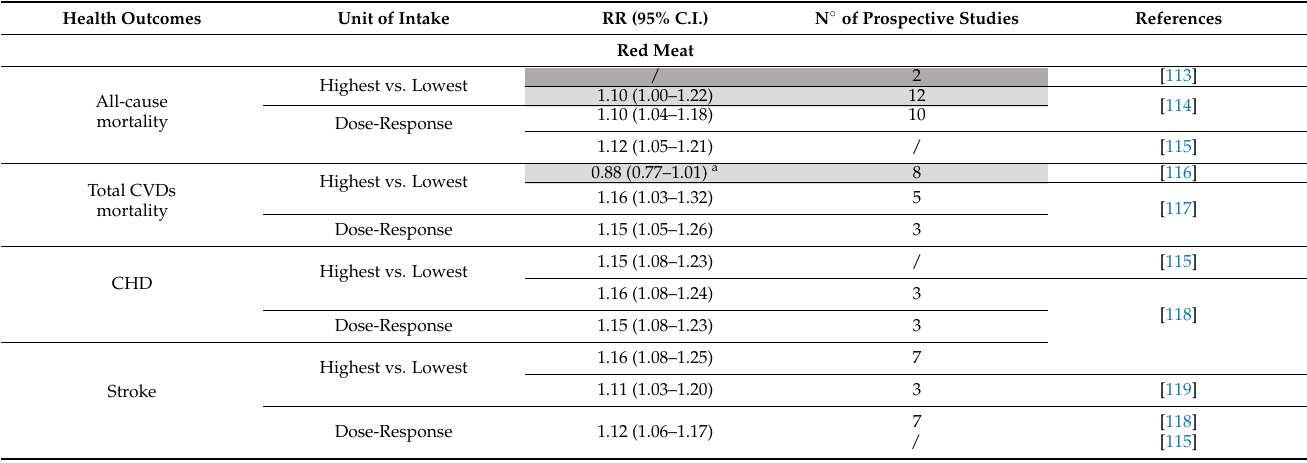
Table 3. Association between red meat, processed meat, and total meat and poultry intake and incidence of some major chronic diseases/mortality of major disease groups (RR, 95% C.I.). The dose-response meta-analysis always refers to an additional serving of a food per day relative to the average intake of that food observed in a cohort study (100 g for total meat, red meat, and poultry; 50 g for processed